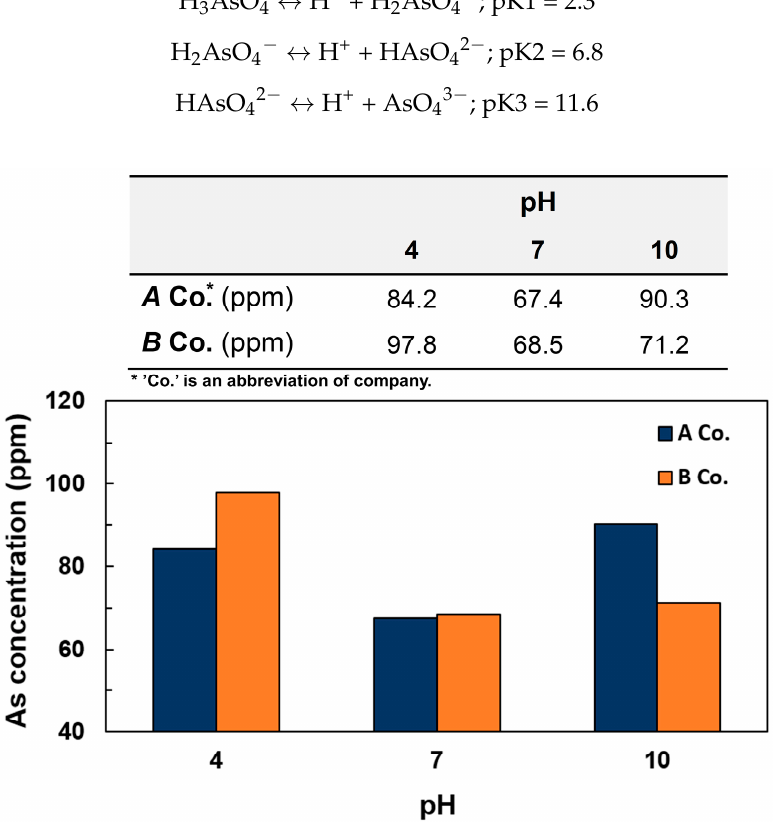
Figure 5. Concentration of arsenic on 25 g of coffee waste extracted from 0.5 mM of arsenic wastewater depending on different pH conditions.